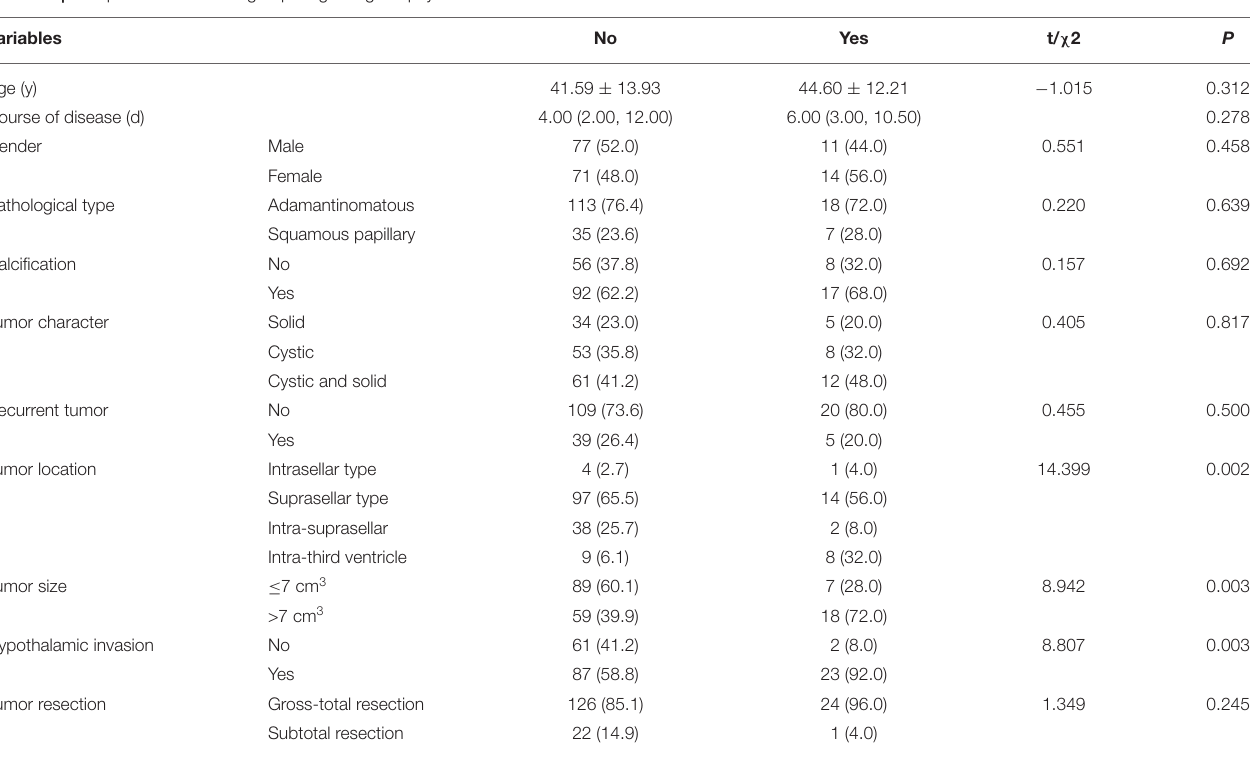
TABLE 2 | Comparison of the two groups regarding the psychiatric